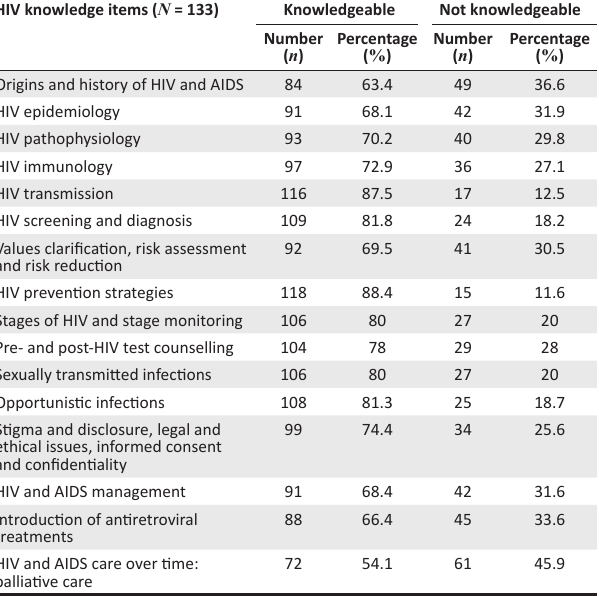
TABLE 1: HIV and AIDS knowledge